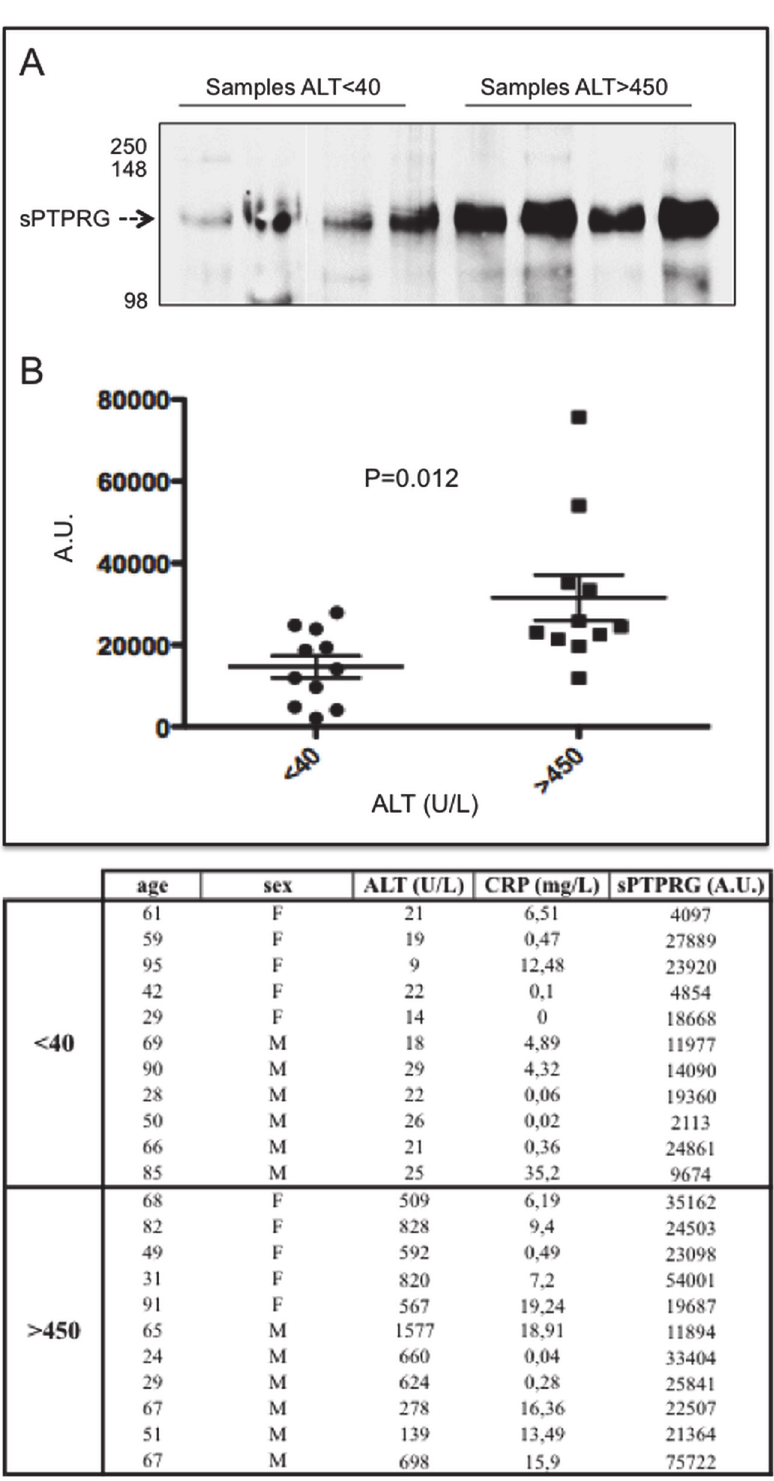
Fig 6. Relationships between liver damage and sPTPRG expression levels in human plasma. Panel A : representative immunoblotting of plasma (immunoprecipitation with CNBR/anti-P4 and WB with the same antibody) and samples from groups with ALT levels < 40 and > 450 U/L. Dashed arrow indicates the soluble PTPRG isoform of * 120 kDa (sPTPRG). Panel B: Samples from individuals with Alanine